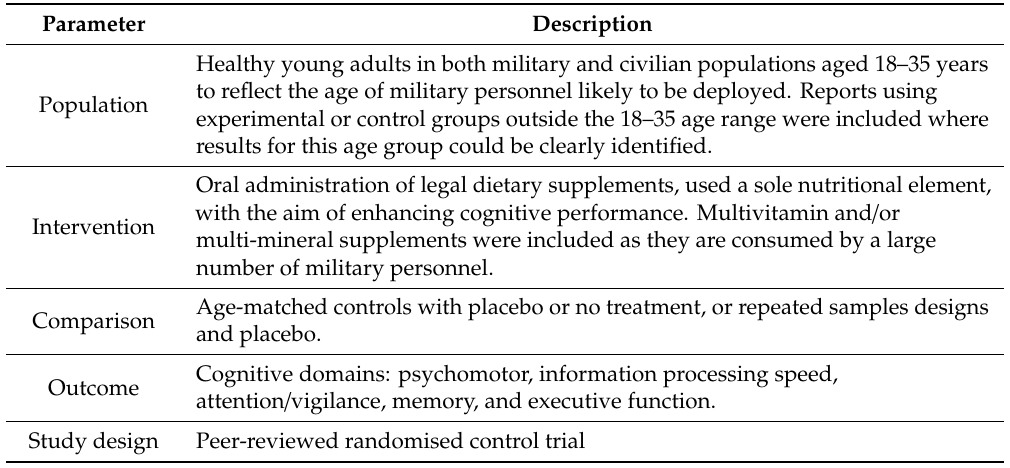
Table 1. Criteria (Participants, Interventions, Comparisons, Outcomes, Study Design–PICOS) used to define the scope of the